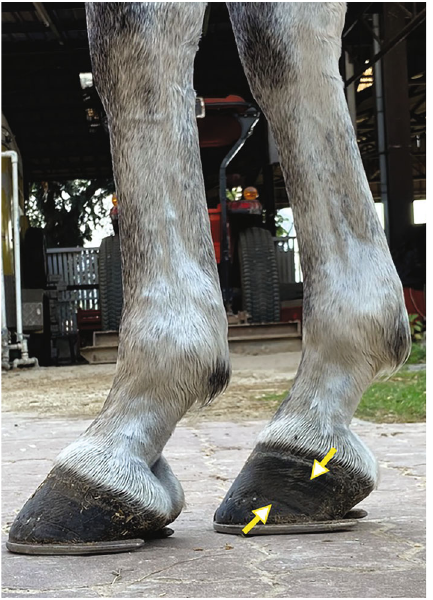
Figure 1: The lateral view image demonstrates a normal hoof- pastern axis in the right foreleg but broken back conformation in the left foreleg. The growth rings were also exhibited in the right hoof wall ’ s medial side (white head of yellow